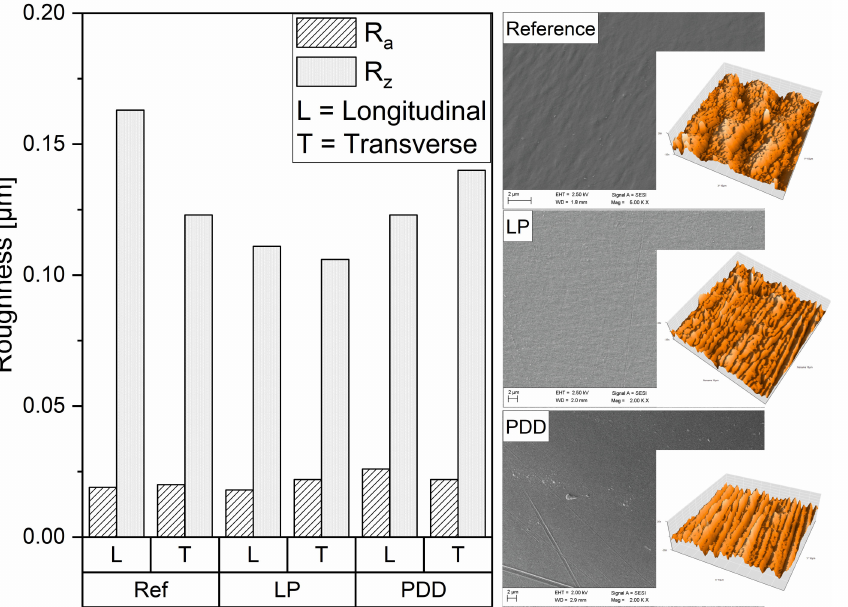
Figure 4. Longitudinal (L) and transverse (T) measured tactile surface roughness of PEEK surfaces modified by atmospheric (PDD, 18 W, 120 s, 10 mm) and low-pressure plasma (LP, 100 W, 120 s) com- pared to the reference ( n = 1) with SEM and AFM images of the reference and the modified